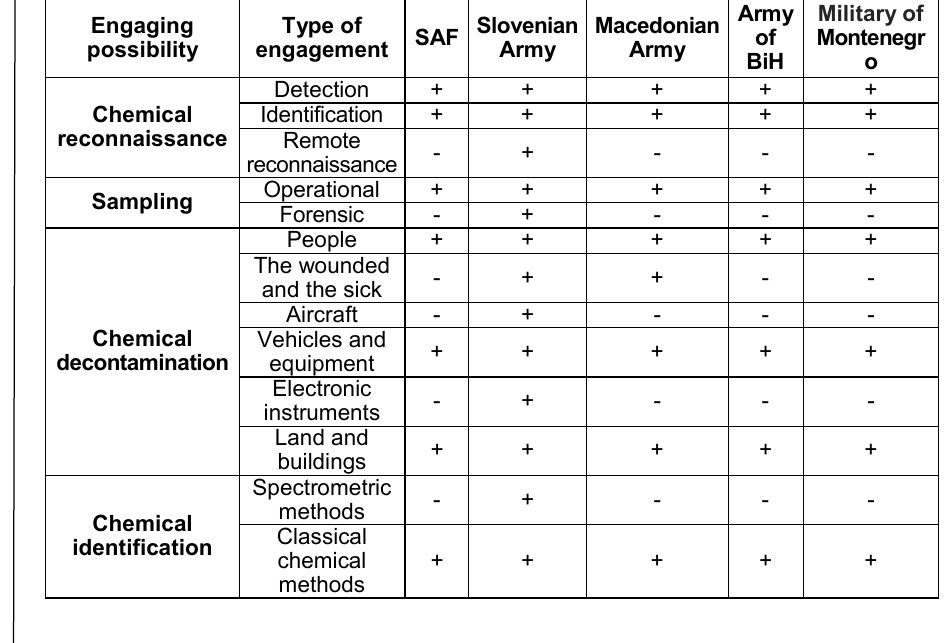
Table 4 – CBRN units capabilities – participants of the „Balkan response 2015“ exercise Таблица 4 – Возможности взводов РХБЗ − участников учений « Балканский ответ